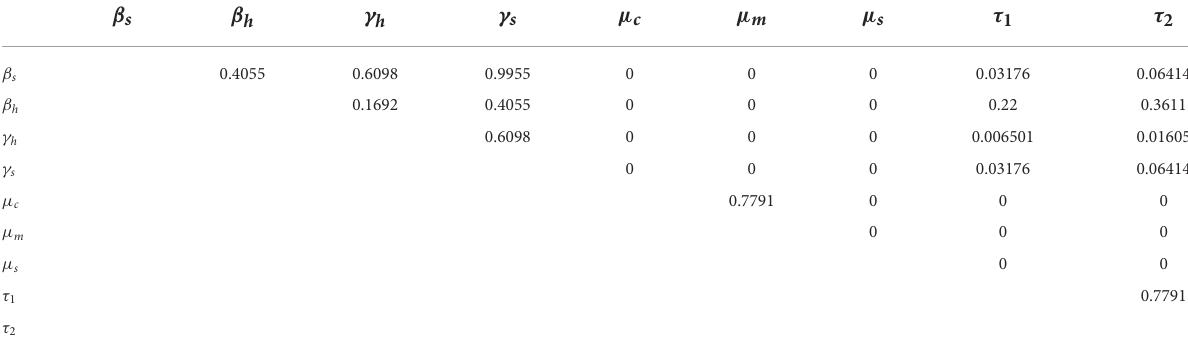
TABLE 5 Pairwise PRCC comparisons (FDR adjusted P